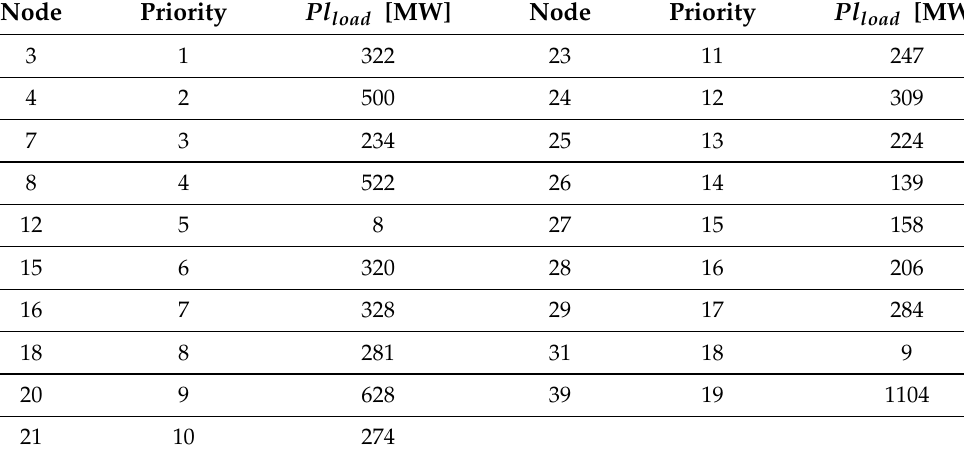
Table 3. Load parameters.